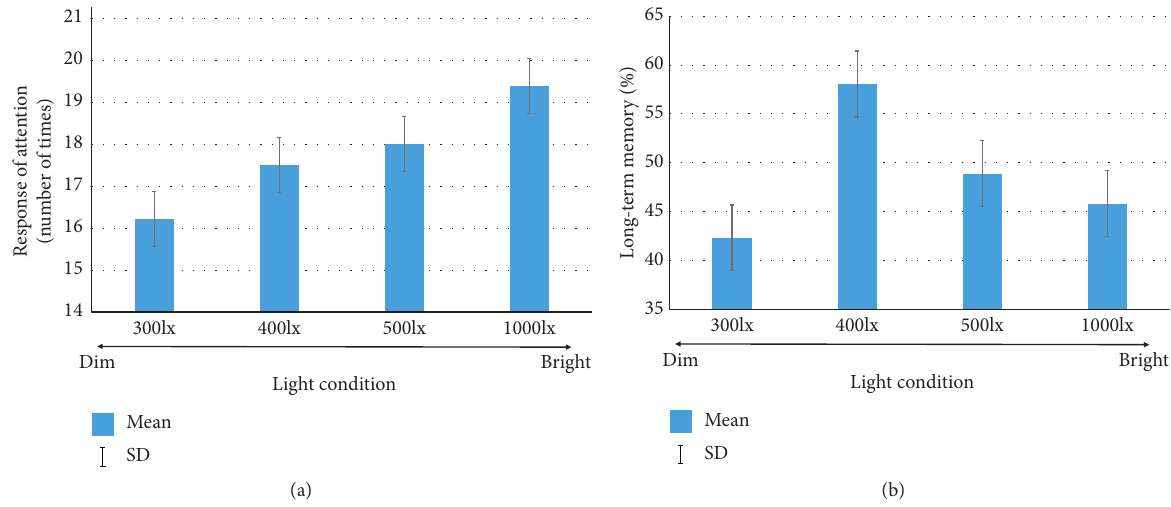
Figure 6: Difference between attention (a) and long-term memory (b) according to illuminance of LED